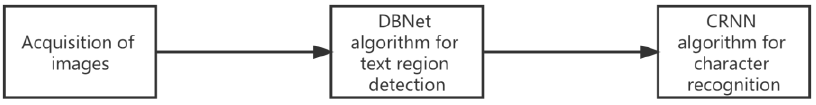
Figure 2. Process for image text detection and recognition based on DBNet-CRNN.